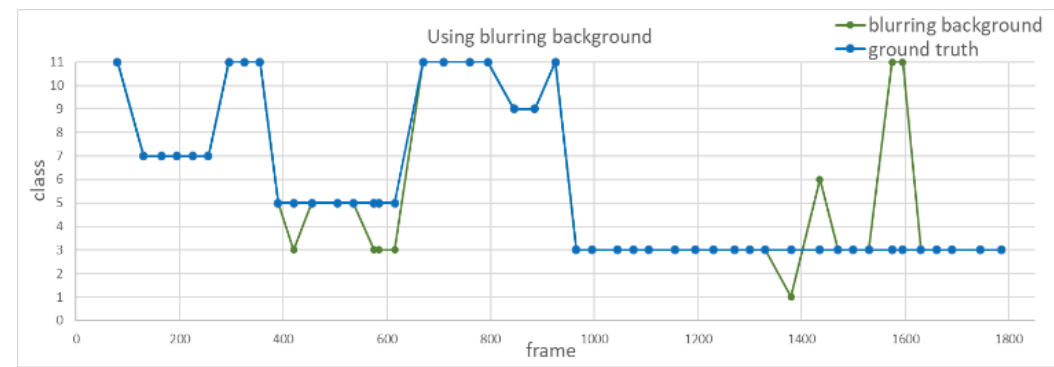
Figure 14. Recognition result using blurred background.